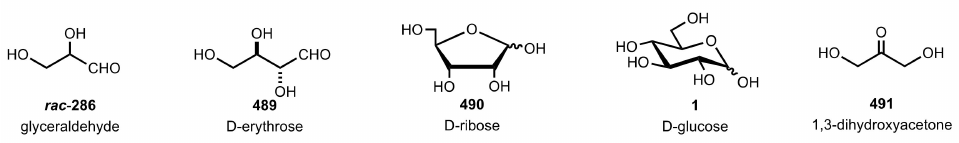
Figure 33. Aldoses and ketose used as organocatalysts in the hydration of α